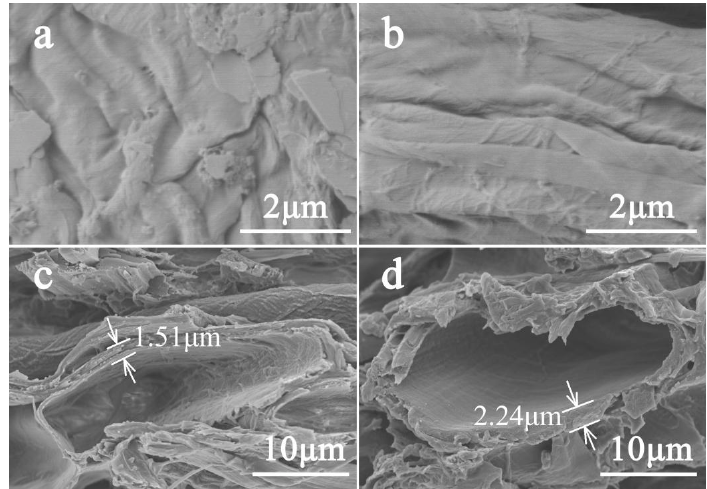
Figure 3. SEM images of sample 1 before ( a ) and after ( b ) treatment with EO-Ar after aging × 20,000, ( c ) and ( d ) the inner wall of untreated and treated fibroblast cavity × 3500. TG and DTG curves of samples 1, 2 and 3 treated and untreated with EO-Ar are dis-